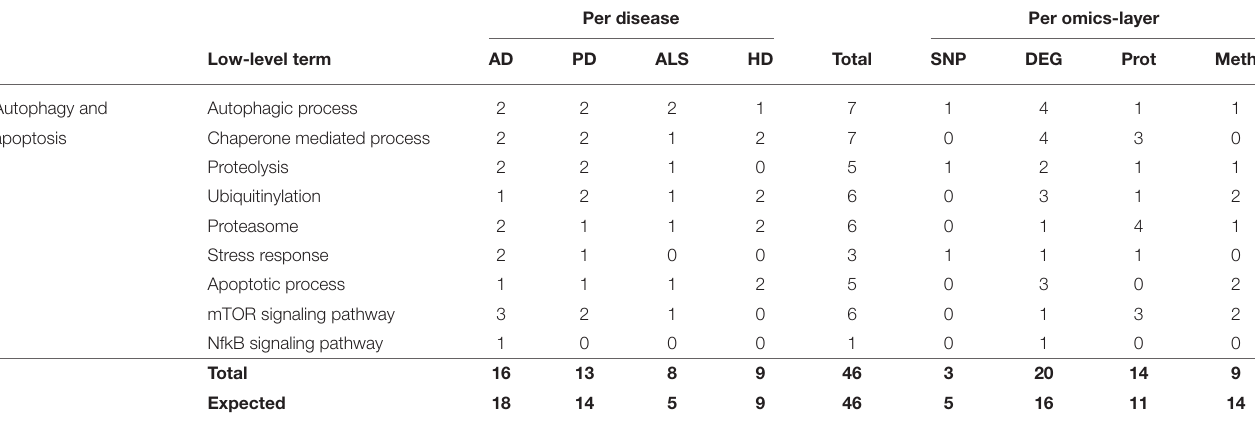
TABLE 4 | Accumulated number of low-level terms per NDD and per omics-layer for the hallmark autophagy and apoptosis. Per disease Per